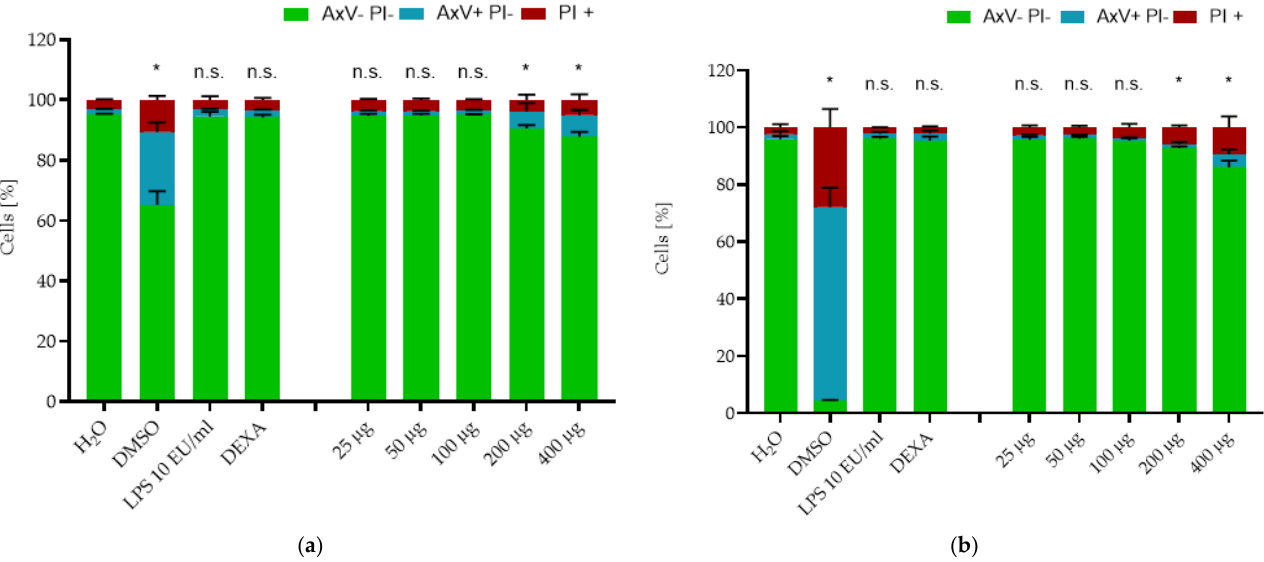
Figure 5. Effects of SPION HAp on the viability of EL4 cells (ATCC ® TIB-39™). Cells were incubated with SPION HAp particle concentrations of 25 to 400 µg/mL and additional controls of H 2 O, DMSO 2%, dexamethasone (DEXA) 0.1 µM, and LPS. After ( a ) 24 and ( b ) 48 h, cells were stained with Annexin A5 FITC conjugate (AxV) and propidium iodide (PI) to detect apoptotic and necrotic cells by flow cytometry. Viable cells (AxV- PI-) are visualized in green, apoptotic cells (AxV+ PI-) in blue and necrotic cells (PI+) in red. Each experiment was performed in triplicate. The mean values are shown with SD. Significance between treatment groups and control (viable cells) at the respective time is indicated by asterisks: * p < 0.05. p values higher than 0.05 were assumed to be not significant (n.s.).